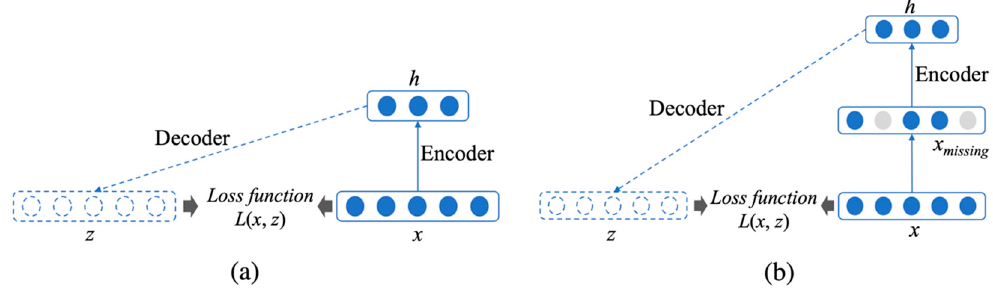
Figure 2. An illustration of a ( a ) standard autoencoder and ( b ) denoising autoencoder. An autoencoder is composed of two parts: encoder and decoder. The encoder takes an input vector x and maps it to a hidden representation h . The decoder takes a hidden representation h to map it to a reconstructed vector z . The aim of an autoencoder is to generate a reconstruction z of the input data such that z ≈ x by minimizing the loss function L ( x , z ) . A denoising autoencoder di ff ers from a standard autoencoder in that the input x is corrupted with noises or missing values.